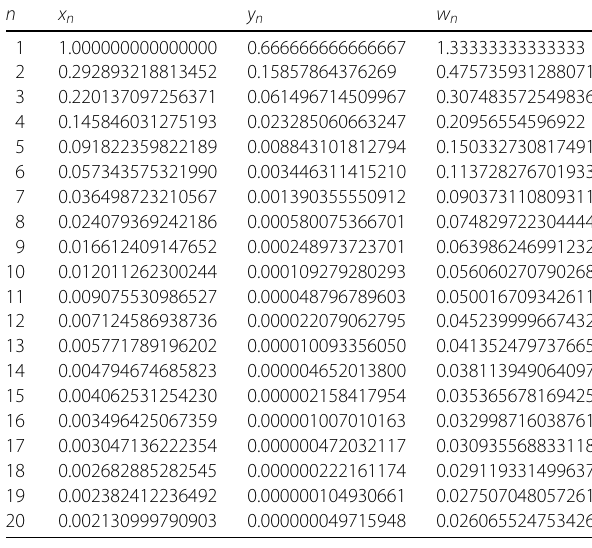
Table 1 Numerical results of { x n } , { y n } , and { w n } with initial x 1 = 1.0 based on (3.10) n x n y n w n 1